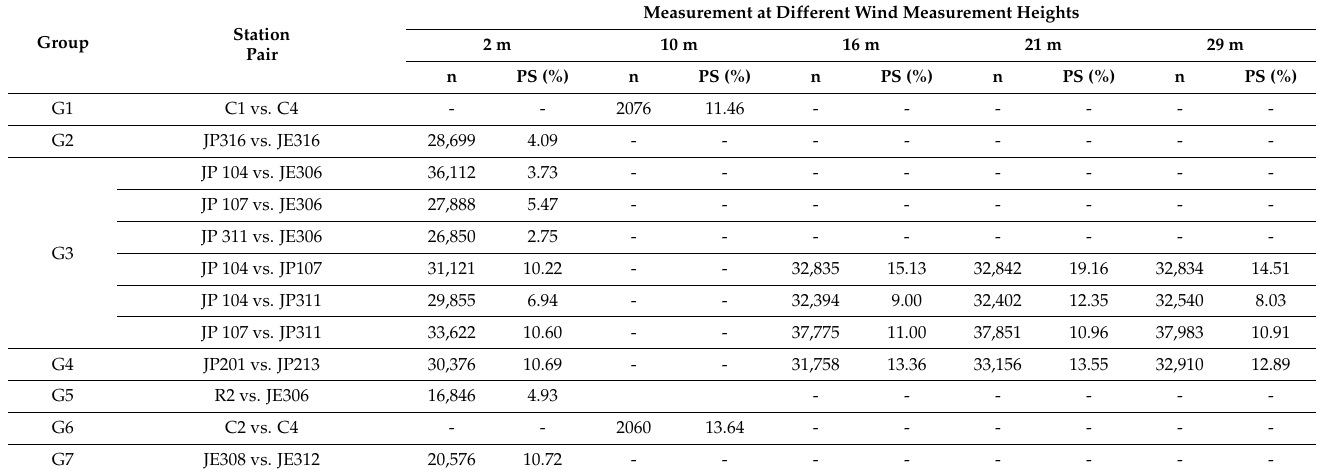
Table 5. Analysis of similarity for available data of wind speed and direction for all seven groups. Here, ‘-’ indicates that measurements were not available (or comparable) for the